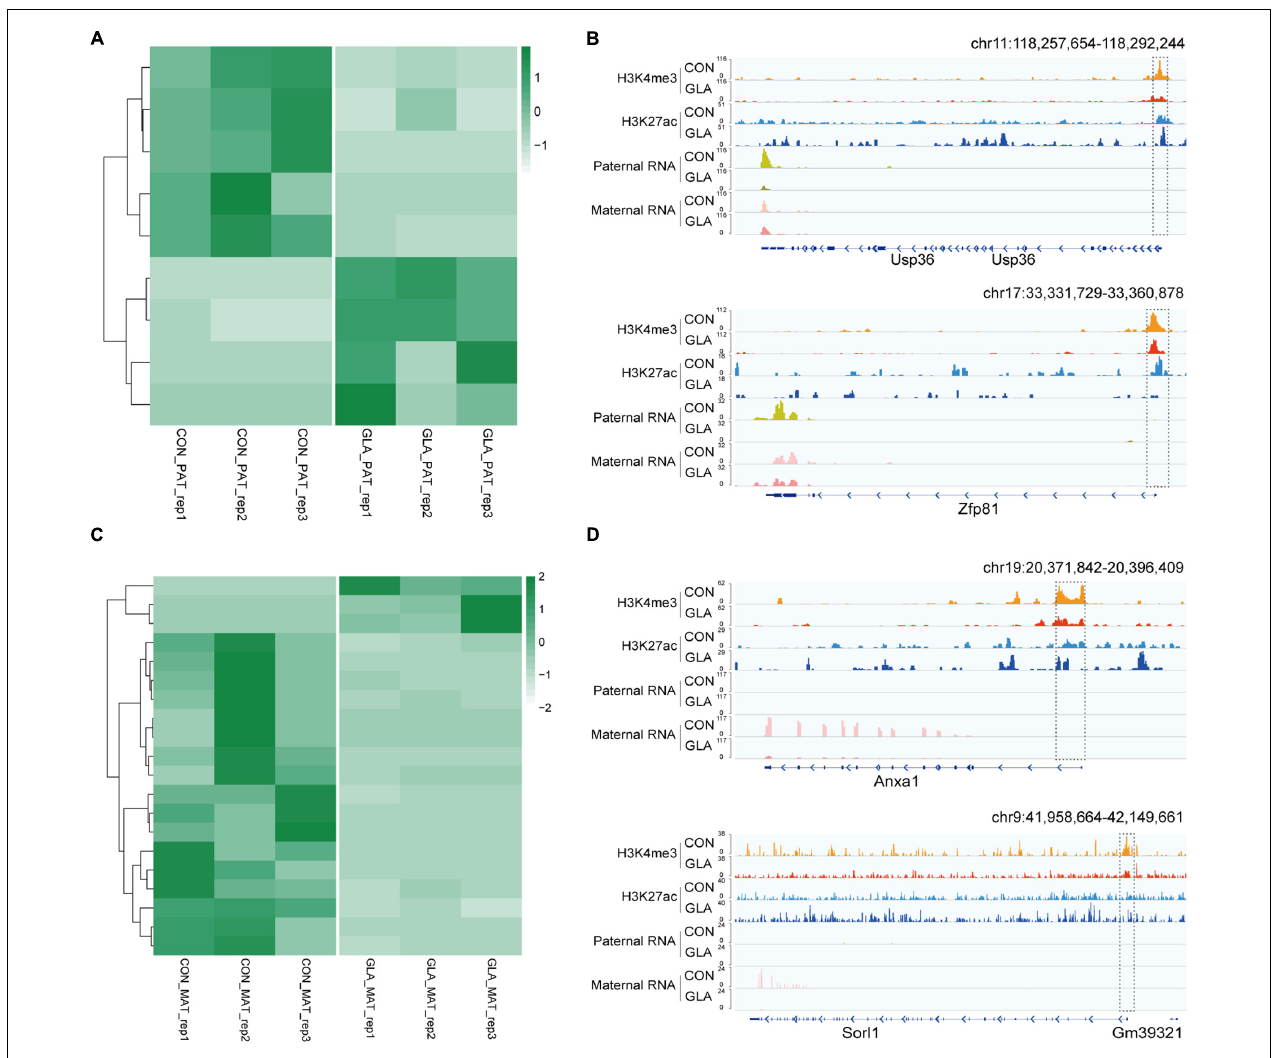
FIGURE 6 | Differentially parental-origin gene expression in 4-cell embryos in connection with H3K4me3 and H3K27ac alterations in GLA sperm. (A) Heatmap of normalized mRNA transcripts of paternal alleles in CON and GLA 4-cell embryos. (B) Integrative Genomics Viewer tracks showing RNA transcripts of parental-specific alleles ( Usp36 and Zfp81 ) in 4-cell embryos integrating with H3K4me3 and H3K27ac signals in GLA sperm. (C) Heatmap of normalized mRNA transcripts of maternal alleles in CON and GLA 4-cell embryos. (D) Integrative Genomics Viewer tracks showing RNA transcripts of parental-specific alleles ( Anxa1 and Sorl1 ) integrating with H3K4me3 and H3K27ac signals in GLA sperm. Dashed box indicates regions with slightly differential histone methylation